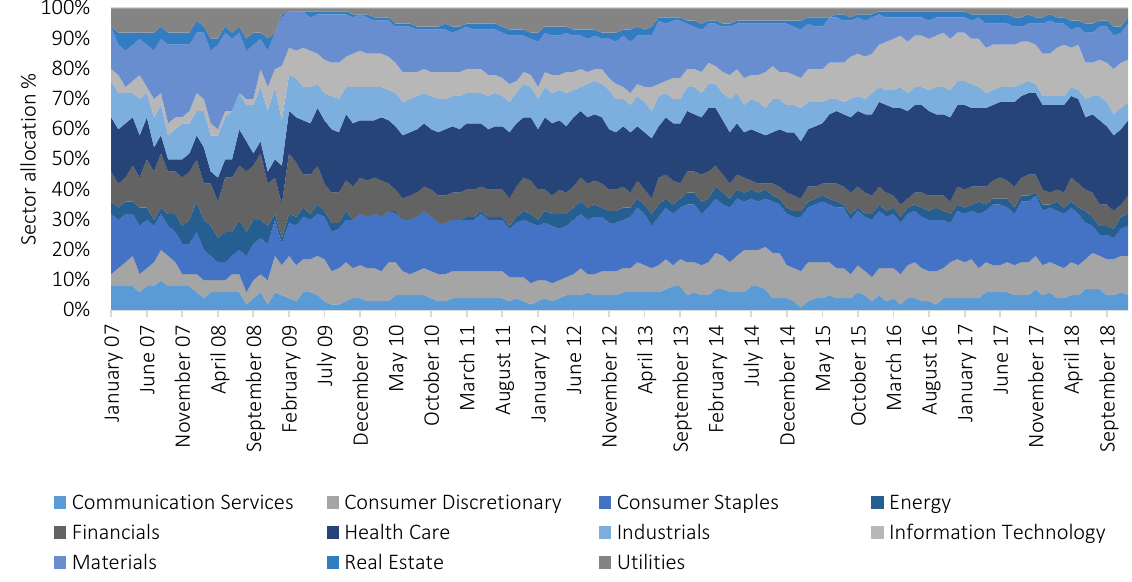
Figure 1c. High-momenturm sorted low-risk portfolio sector profile